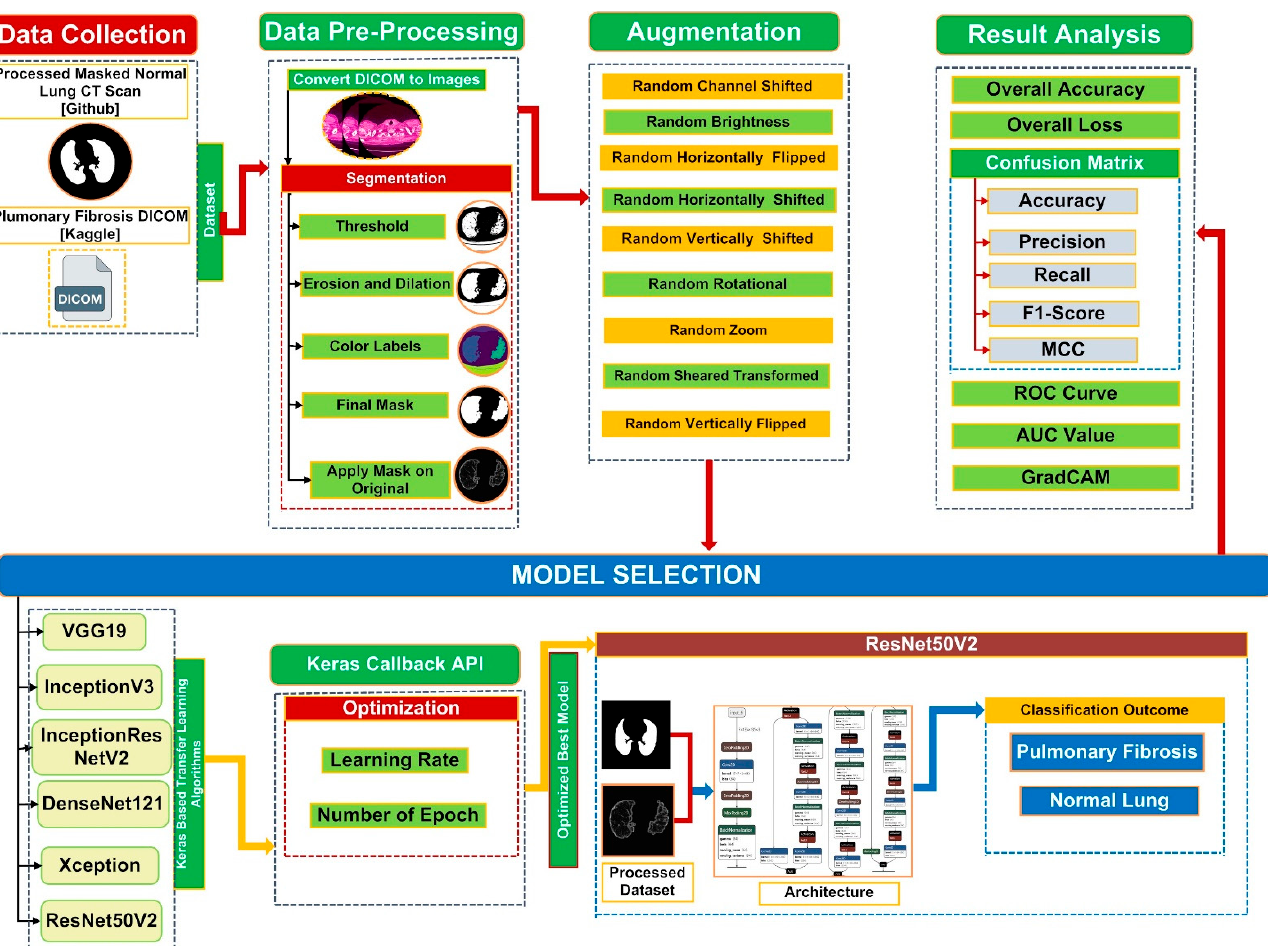
Figure 2. Illustration to show the main structure of the proposed system to screen optimized deep transfer learning models to classify and detect PF from chest CT images.